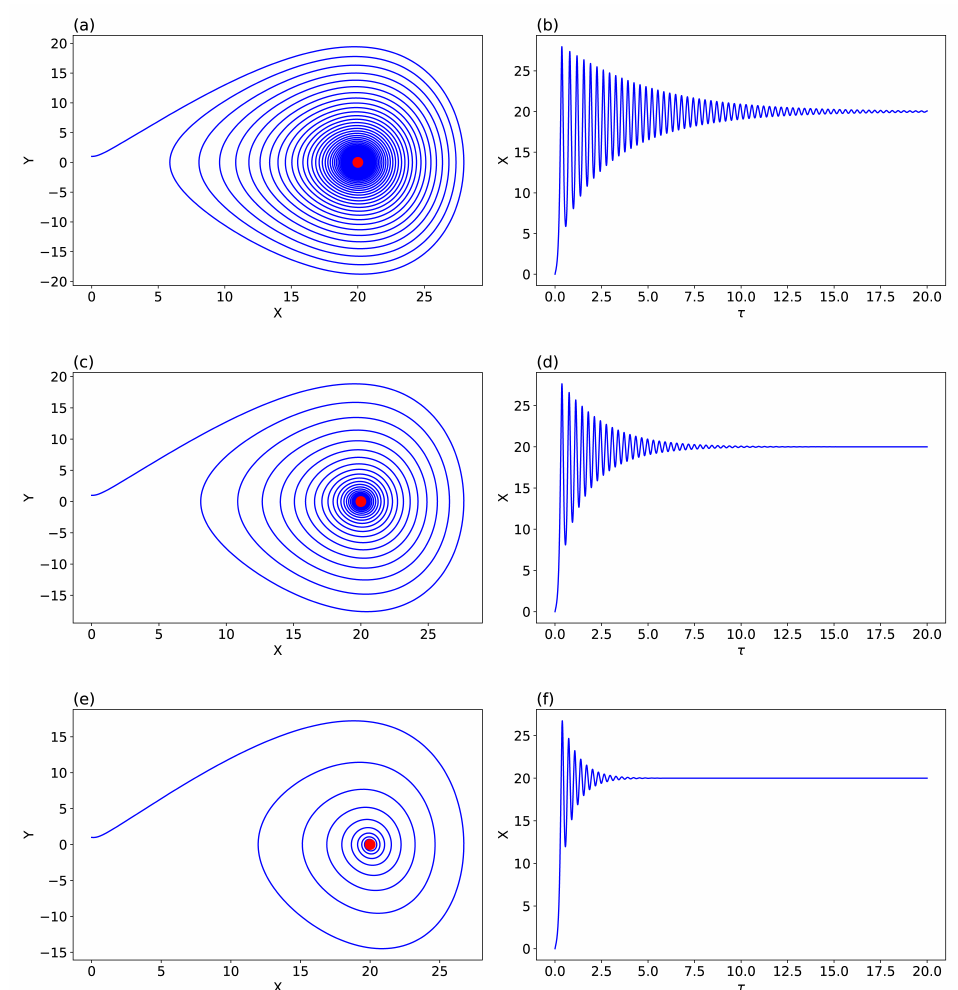
Figure 2. Solutions for the simplified Lorenz model that only contains one dissipative term, and (cid:101) = 0.5,1, and 2.5, from top to bottom. Left panels ( a , c , e ) display orbits within the X while right panels ( b , d , f ) depict the time evolution of X . A stable non-trivial critical point is indicated by a large red